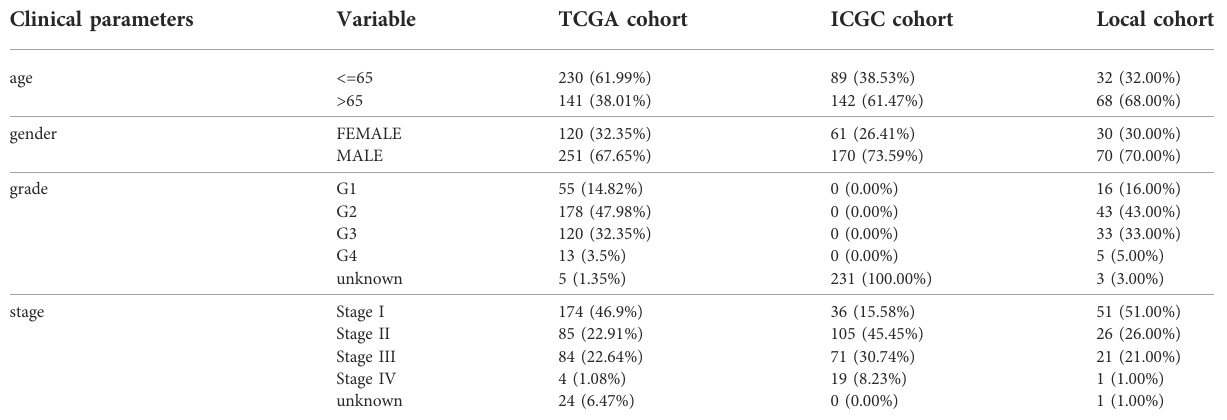
TABLE 1 Speci fi c clinical parameters for the TCGA, cohort, ICGC, cohort and local cohort. Clinical